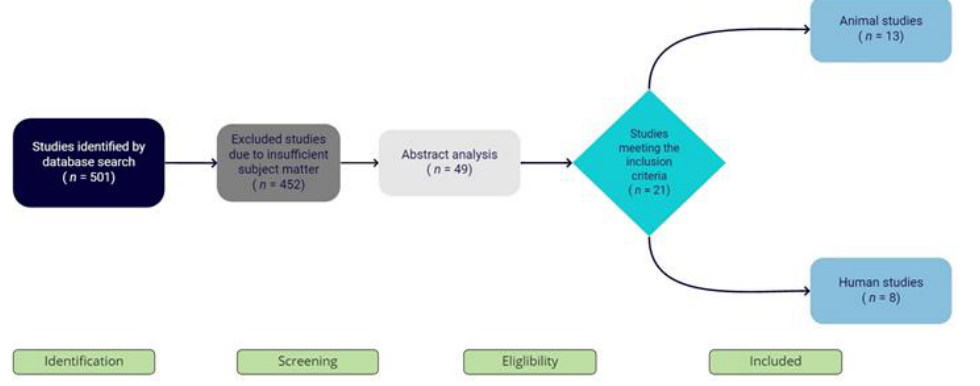
Figure 2. Prisma flowchart of search results. Table 3. PICO criteria.